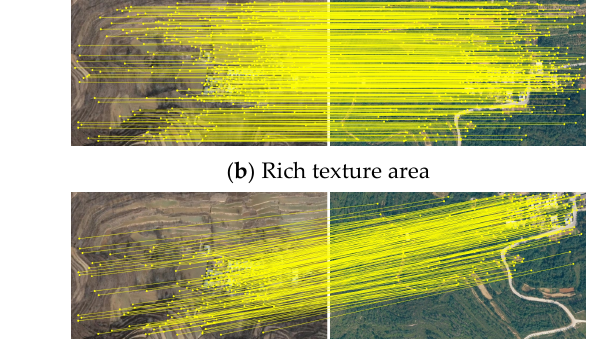
Figure 13. Partial matching results of Superpoint + Superglue on the test dataset.